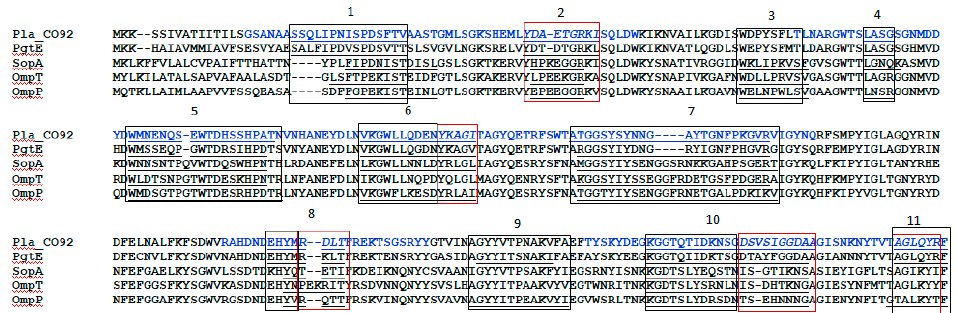
Figure 1. Identification of four major reactive epitopes (indicated in blue) within the pro-omptin molecule and their homology with other omptin family proteases. Alignment of the omptins of